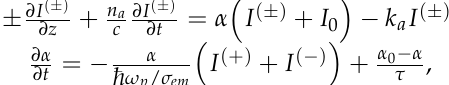
Figure 8. The simulation results of the mode ‐ locked laser oscillation for the shutter with t open = 2 ns at ( a ) φ = 17°, ( b ) φ = 27°, and ( c ) φ =